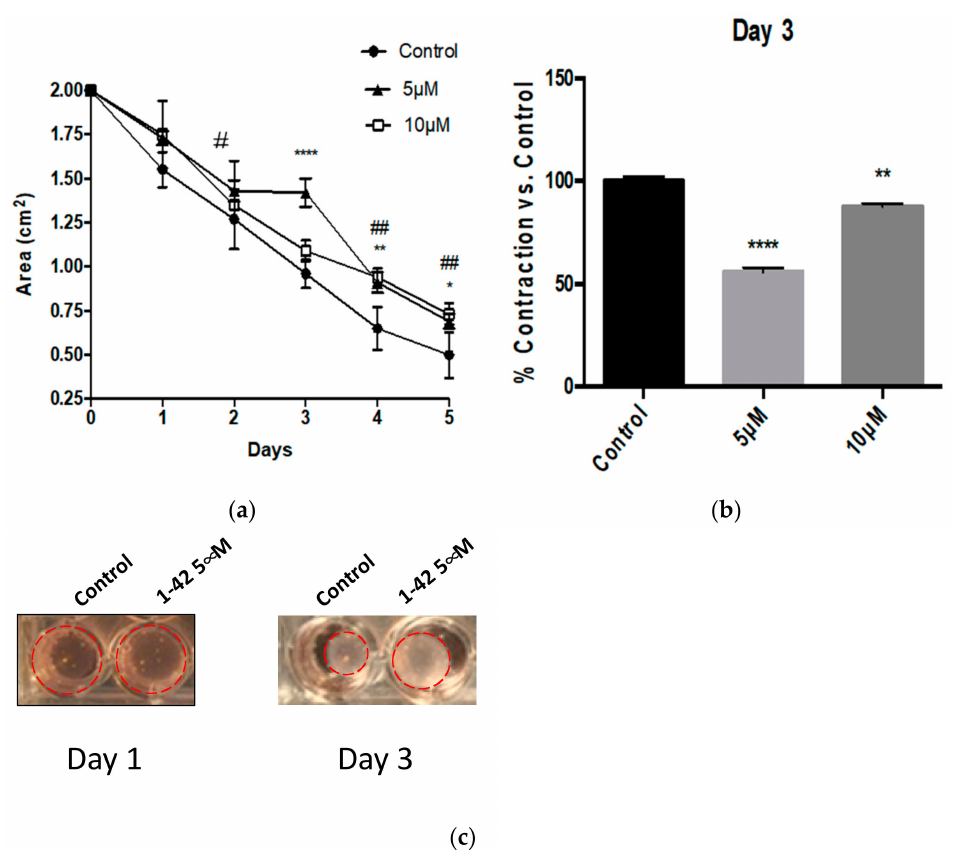
Figure 1. A β 1-42 peptide decreased HBVSMC contractility. ( a ) Human brain vascular smooth muscle cells (HBVSMC) treated with 5 or 10 µ M of A β 1-42 exhibit significantly larger area after 3 days of treatment (days 3–5). ( b ) A β 1-42 decreased HBVSMC contractility at day 3 significantly compared with control n = 4, * p < 0.05, ** p < 0.01, **** p < 0.001 for 5 uM treatment vs. control on each day, # p < 0.05, ## p < 0.01 for 10 uM treatment vs. control each day; one-way ANOVA with Dunnett’s post-testing; data are mean ± SEM. ( c ) Representative figure of HBVSMC/collagen gels incubated with or without 5 µ M of A β 1-42 peptides over the period of 3 days. Red dashed lines indicate the outline of the HBVSMC/collagen gels which were used to calculate the